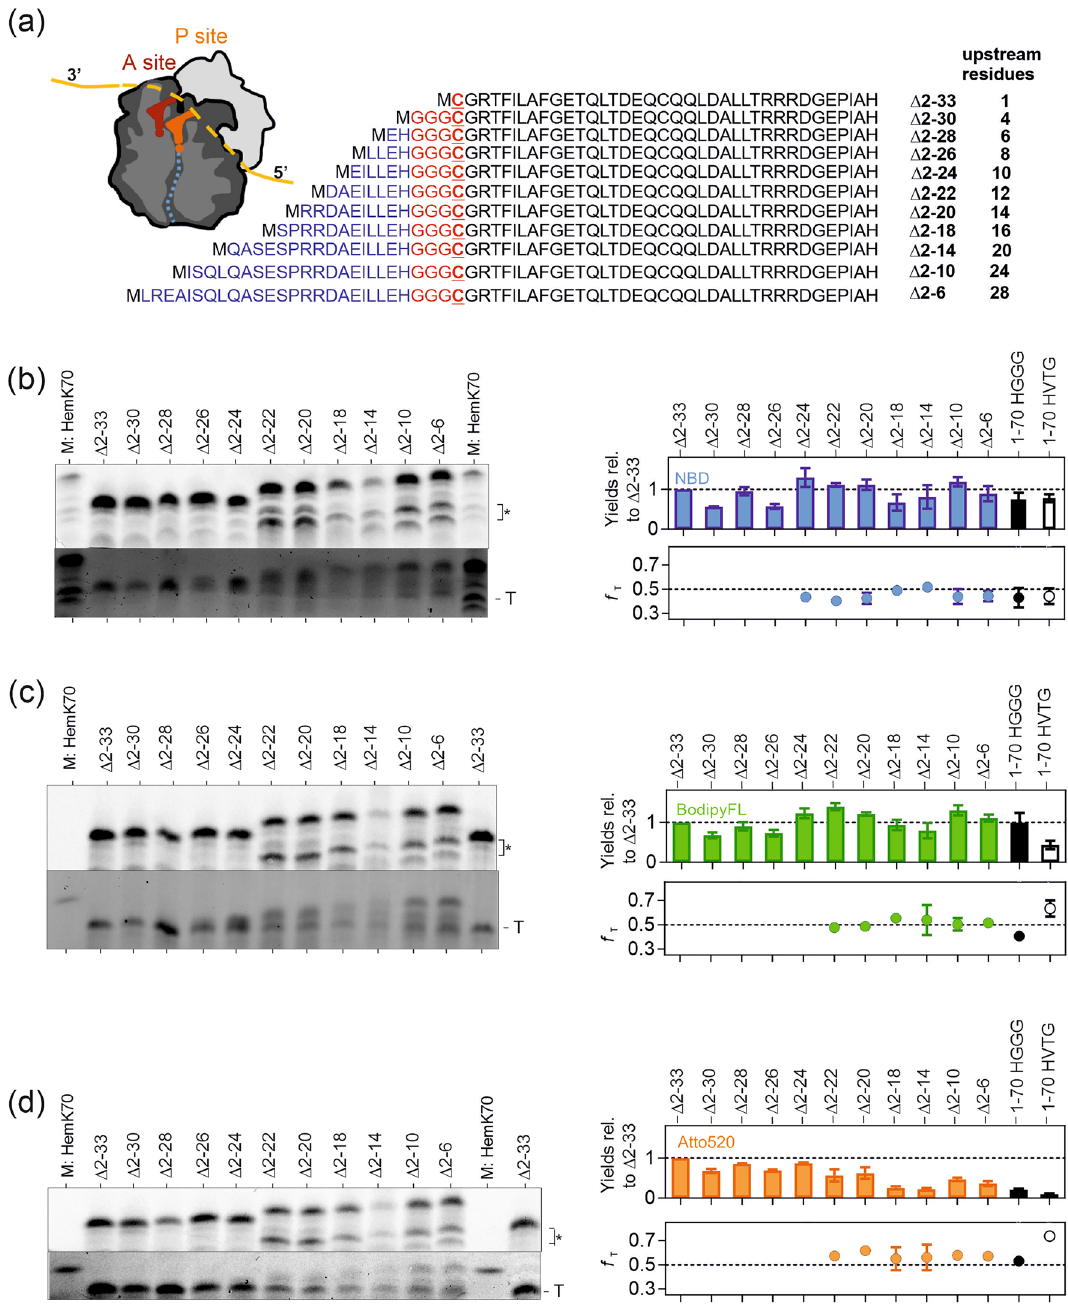
Figure 4. Upstream nascent peptide length effect. ( a ) Sequence of the HemK constructs. All construct except for Δ2-33 contained a GGG sequence upstream of the Cys34 codon. The structural cartoon shows the nascent polypeptide attached to the peptidyl-tRNA in the P site prior to peptide bond formation with RCys-tRNA Cys in the A site. ( b ) Left panel: Visualization of nascent chains containing Atto655Met1 (top gel) or NBDCys (bottom gel) by SDS-PAGE as described in Fig. 2. An asterisk indicates short peptide products resulting from ribosome stalling prior to codon 34. Right panel: The sum of F and T products (NBDCys signal) for different upstream nascent chain lengths, shown relative to that for the shortest construct Δ2-33 (top panel) and the f T values (bottom panel). The values for HemK 1–70 HGGG (from Fig. 3) and HemK 1–70 HVTG (from Fig. 2) are shown as black or white symbols, respectively. ( c ) and ( d ) are same as ( b ) for BodipyFLCys and Atto-520-Cys, respectively, with the exception that marker M:HemK70 contained only peptides with the N-terminal